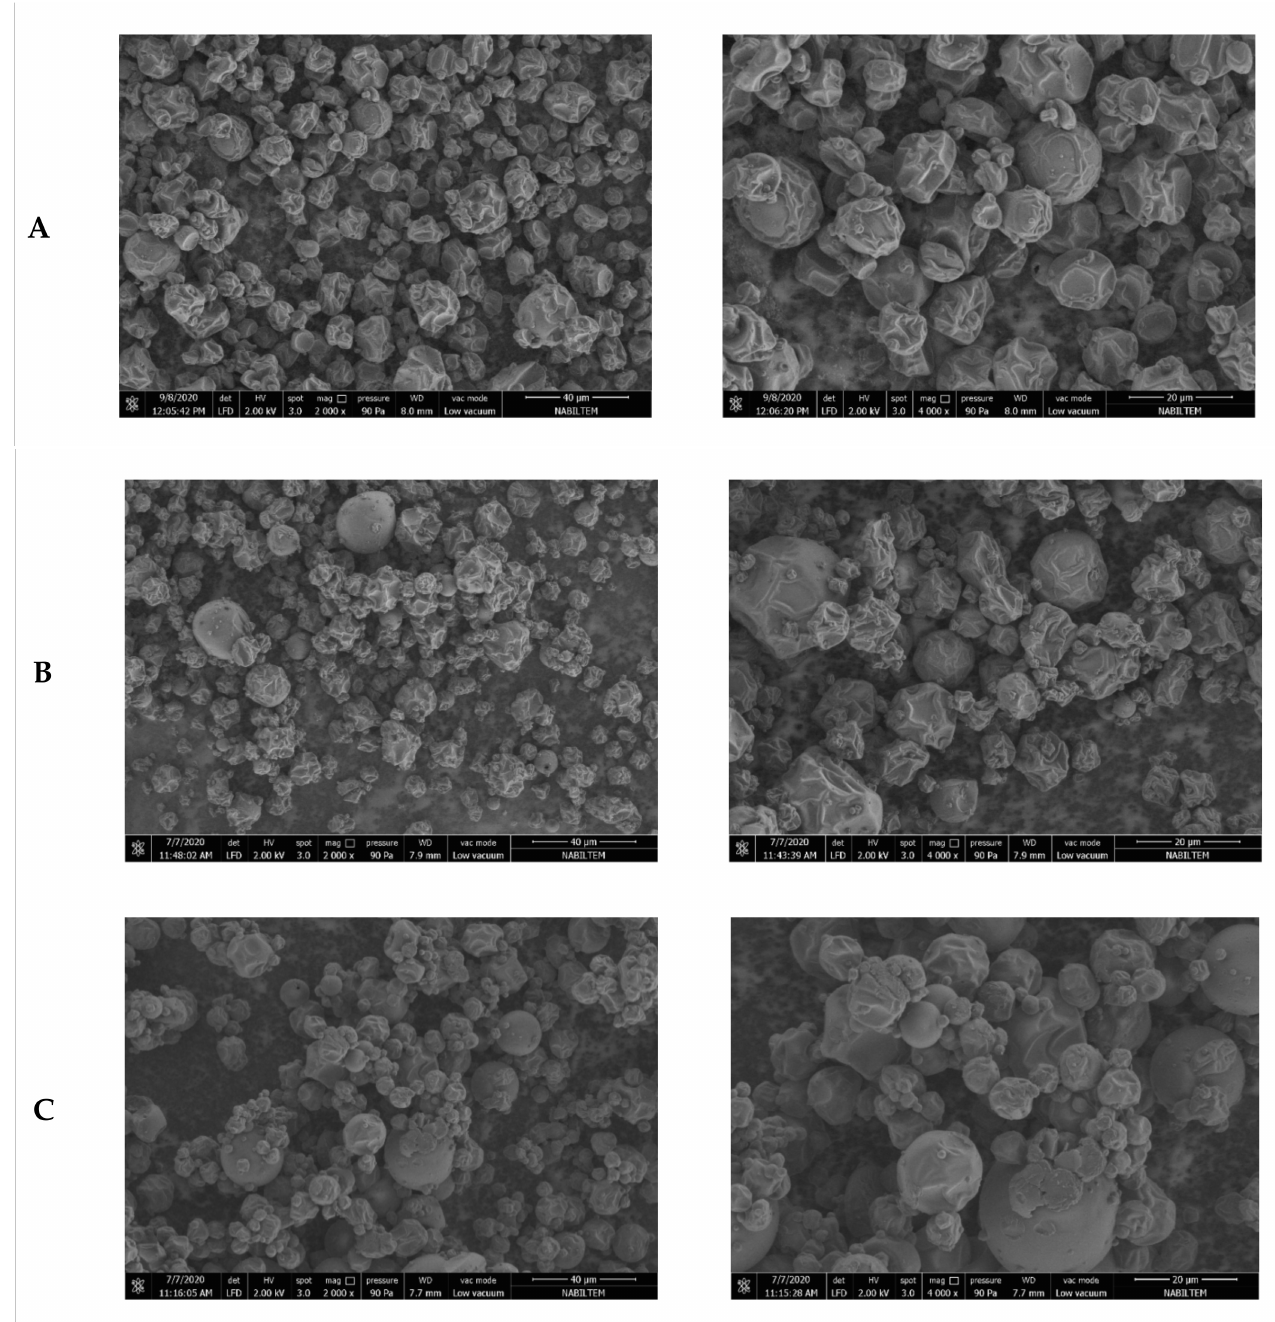
Figure 2. Scanning electron microscopy images of loaded chitosan-coated liposome powder ( A ), loaded whey protein-coated liposome powder ( B ), and water extract powder ( C ). Pictures were taken at 2000 × and 4000 × magnifications,